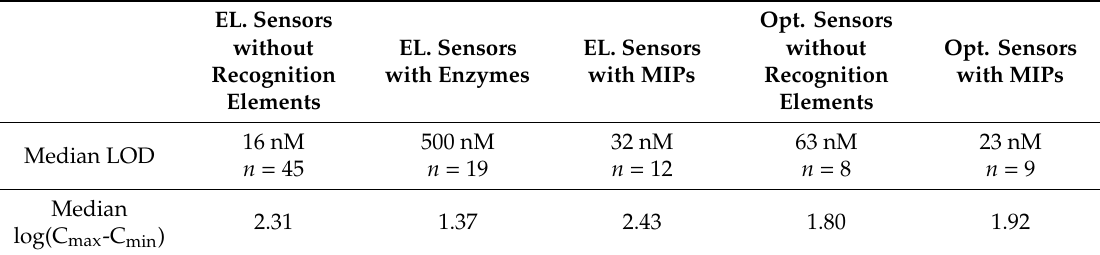
Table 4. Comparison of target detectability of the sensors reported in this